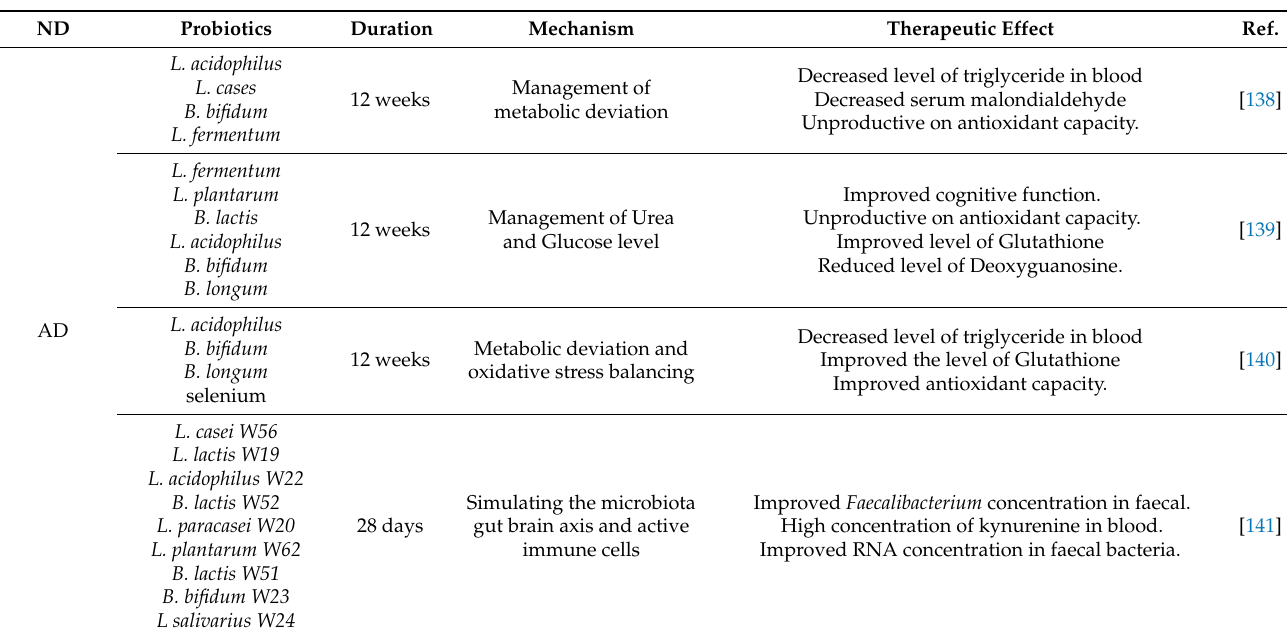
Table 4. Recent clinical studies of ND with combination or singular probiotic with their therapeutic effect and mechanism of